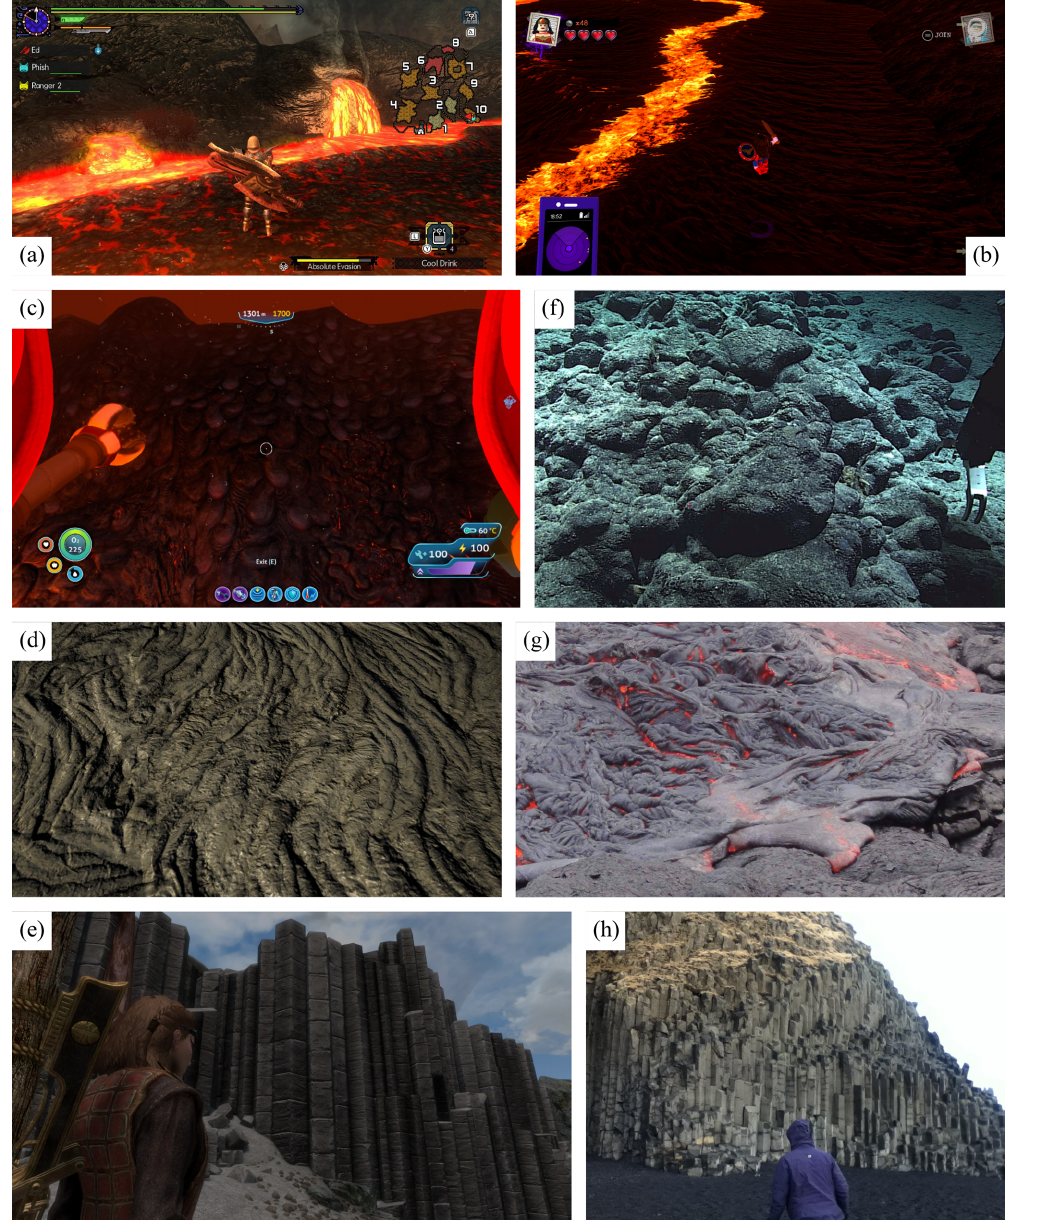
Figure 2. Lava surfaces in Monster Hunter: Generations Ultimate © Capcom (2018; a ), ropey pahoehoe textures in LEGO DC Super- villains © TT Games Ltd (2018; b ), pillow lavas in Subnautica © Unknown Worlds Entertainment (2018; c ), more ropey pahoehoe textures in Assassin’s Creed Odyssey © Ubisoft (2018; d ) and columnar textures in The Elder Scrolls: Skyrim © Bethesda Game Studios (2016; e ). Real-world examples of pillow lavas (Keoea Seamount, NOAA, 2015; f ), ropey pahoehoe textures (Hawaii, Lis Gallant, 2013; g ) and basaltic columnar textures (Iceland, Edward McGowan, 2014; h